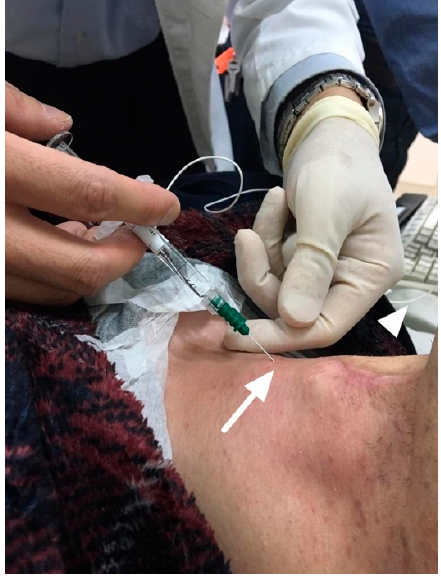
Figure 7. Hyaluronic acid injection laryngoplasty without anesthesia, guided by laryngeal electromyography injectable needle electrode connected to electromyography machine (arrow